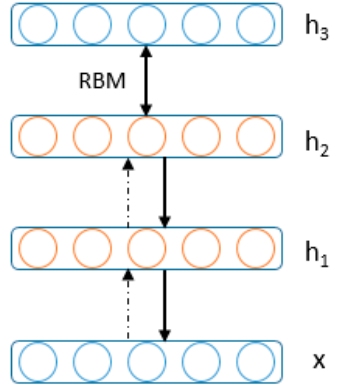
Figure 37. Block diagram for Restricted Boltzmann Machine (RBM).